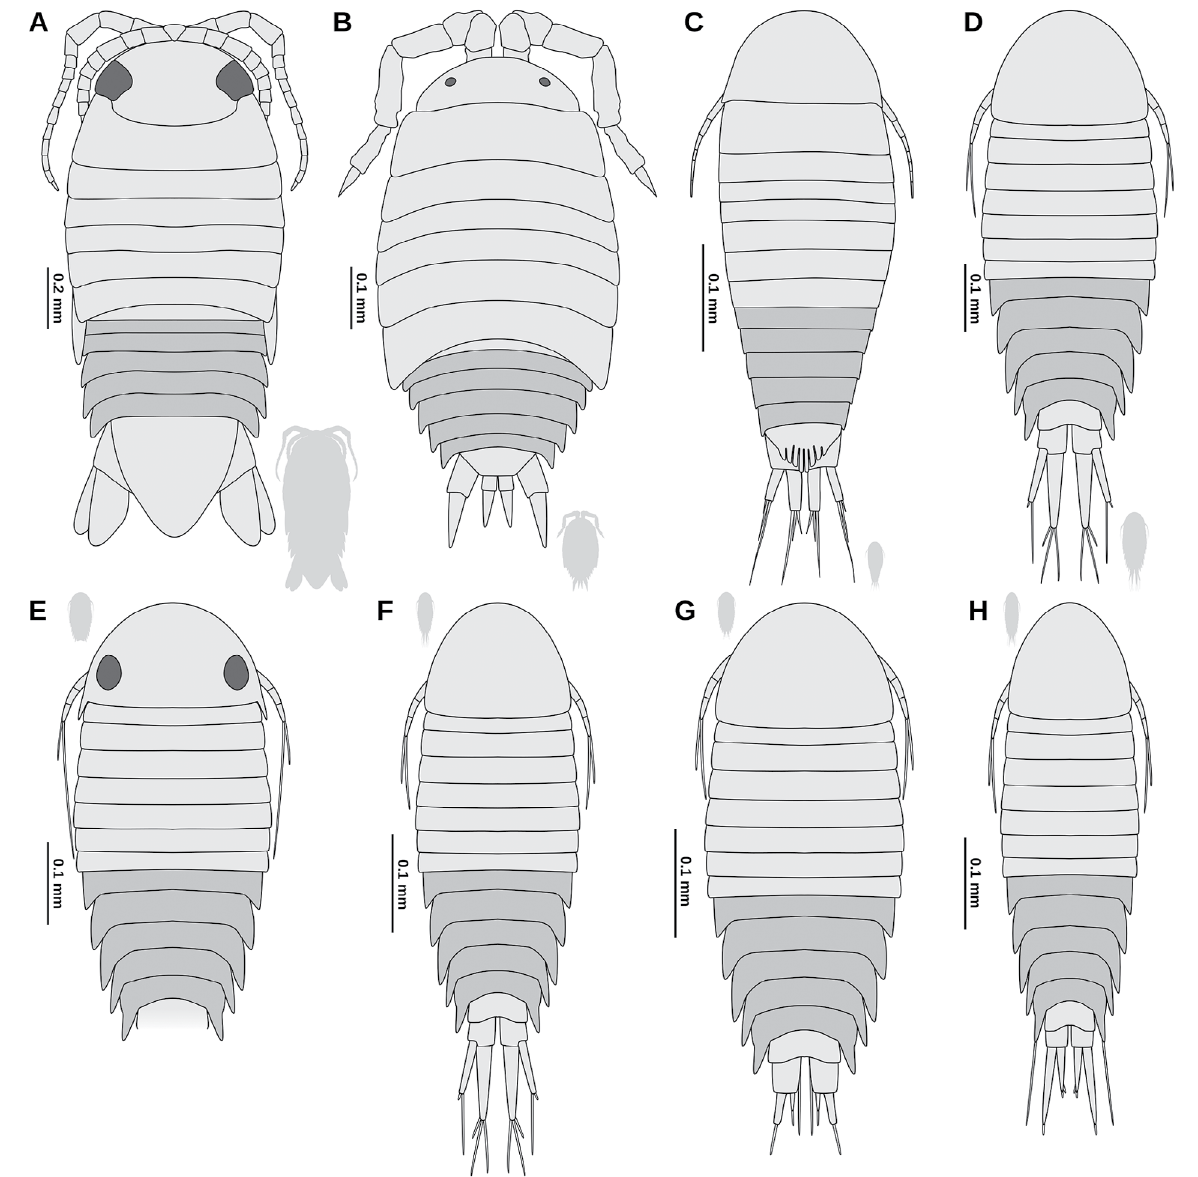
Figure 10. Graphical summary of all known manca-stage or larval fossils of Isopoda, reconstruction line drawings, free pleon tergites (postocular segments 14–18) in darker grey. A. Paratype of Electrolana madelineae sp. nov. (NHMW 2017/0052/0002); B : Aquitanoscia chiapasensis Broly et al. , 2017; C : Vacuotheca dupeorum Schädel et al. , 2019b; D : IHNFG-4951-Ep1 (‘specimen 2’) Serrano Sanchez et al. (2016); E : openstreetmap.org IHNFG-4964-Ep2 (‘specimen 5b’) Serrano Sanchez et al. (2016); F : IHNFG- 5321-Ep1 (‘specimen 6’) Serrano Sanchez et al. (2016); G : IHNFG-4971-Ep1 (‘specimen 3’) Serrano Sanchez et al. (2016); H : IHNFG-4939-Ep1 (‘specimen 1’) Serrano Sanchez et al.